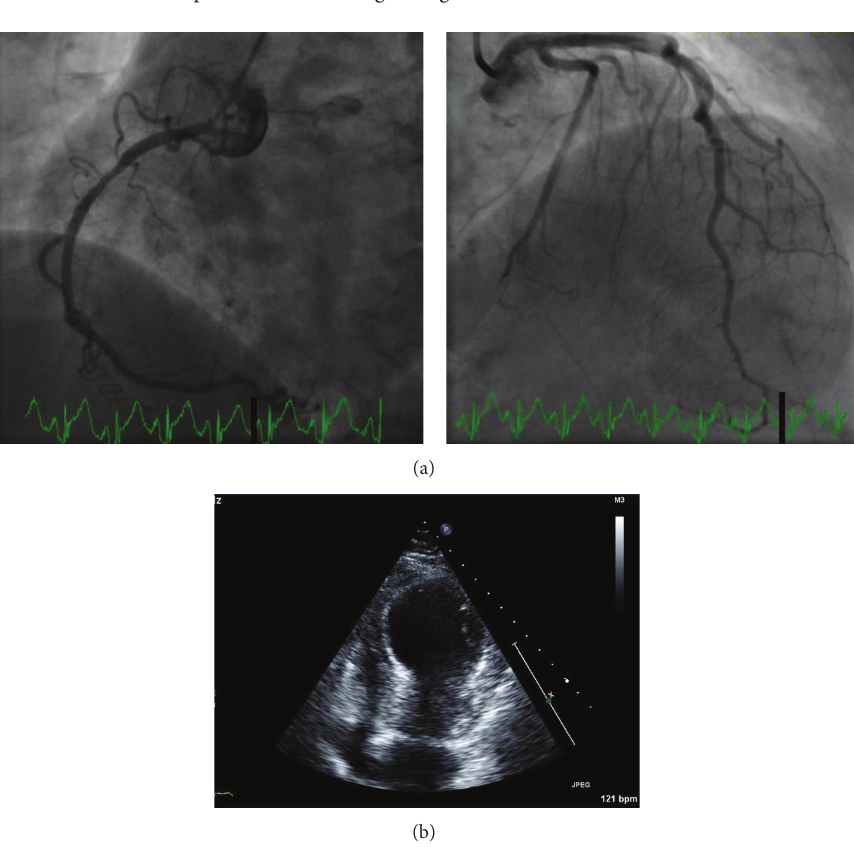
Figure 2: (a) Coronary angiography showing nonobstructing 30% stenosis of right coronary artery with otherwise normal coronary arteries. (b) Transthoracic echocardiogram showing anteroapical and infra-apical wall hypokinesis with ejection fraction of 20%.